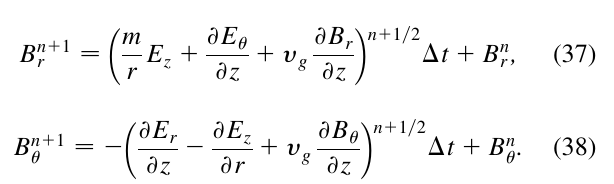
FIG. 7. Schematic illustrating the initialization of the simula- tions. (a) The beam with axial speed v stationary simulation box ( v tionary until the head beam is 50 cm from the end of the simulation region. (c) At this time the simulation box moves forward at the beam speed ( v